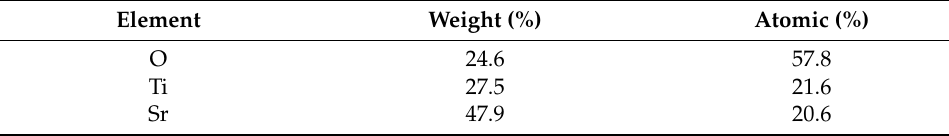
Figure 10. EDS analysis for SrTiO 3 :Rh. Table 3. Element composition ratios of SrTiO 3 :Rh by